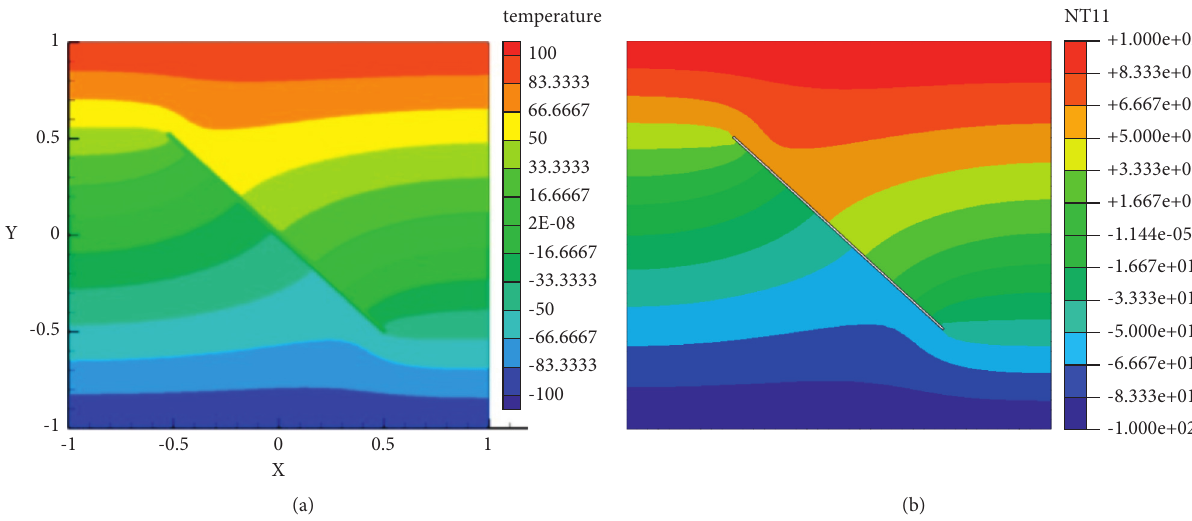
Figure 12: A comparison of temperature contour in case of adiabatic inclined crack when t � 100s and at X � 0 or (L/2). (a) PD. (b)